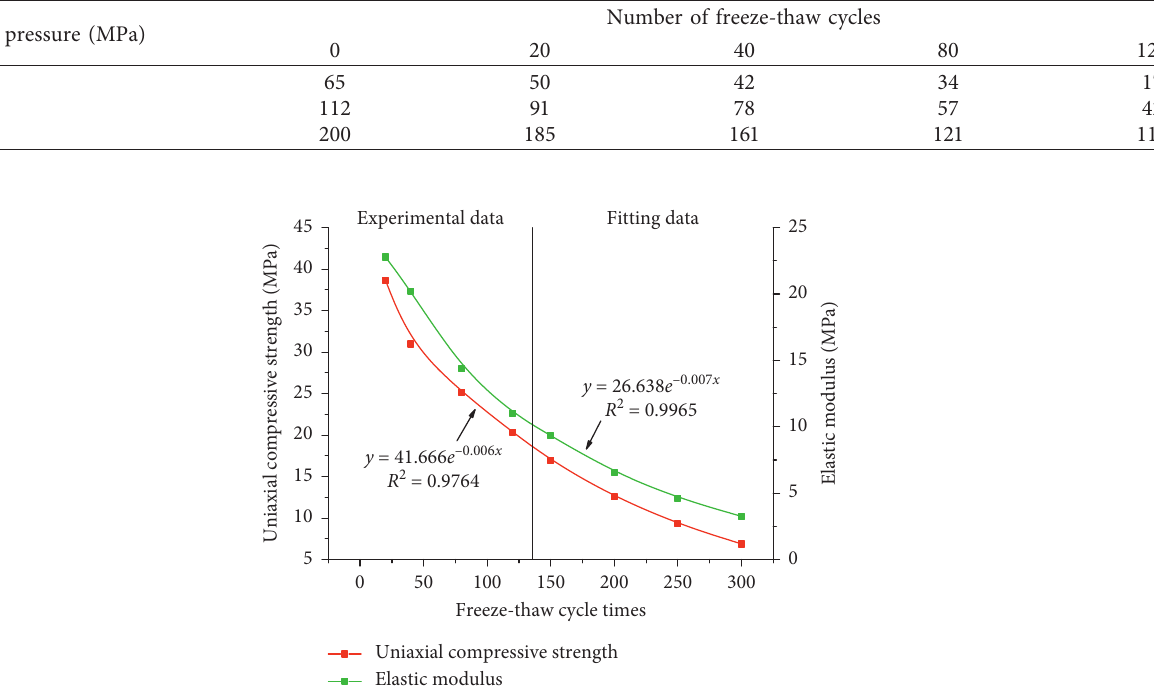
Figure 7: Fitting formulas for static compressive strength and elastic modulus of sandstone with different freeze-thaw cycles. Table 3: Fitting values of physical and static parameters of sandstone under multiple freeze-thaw cycles. Number of freeze-thaw cycles